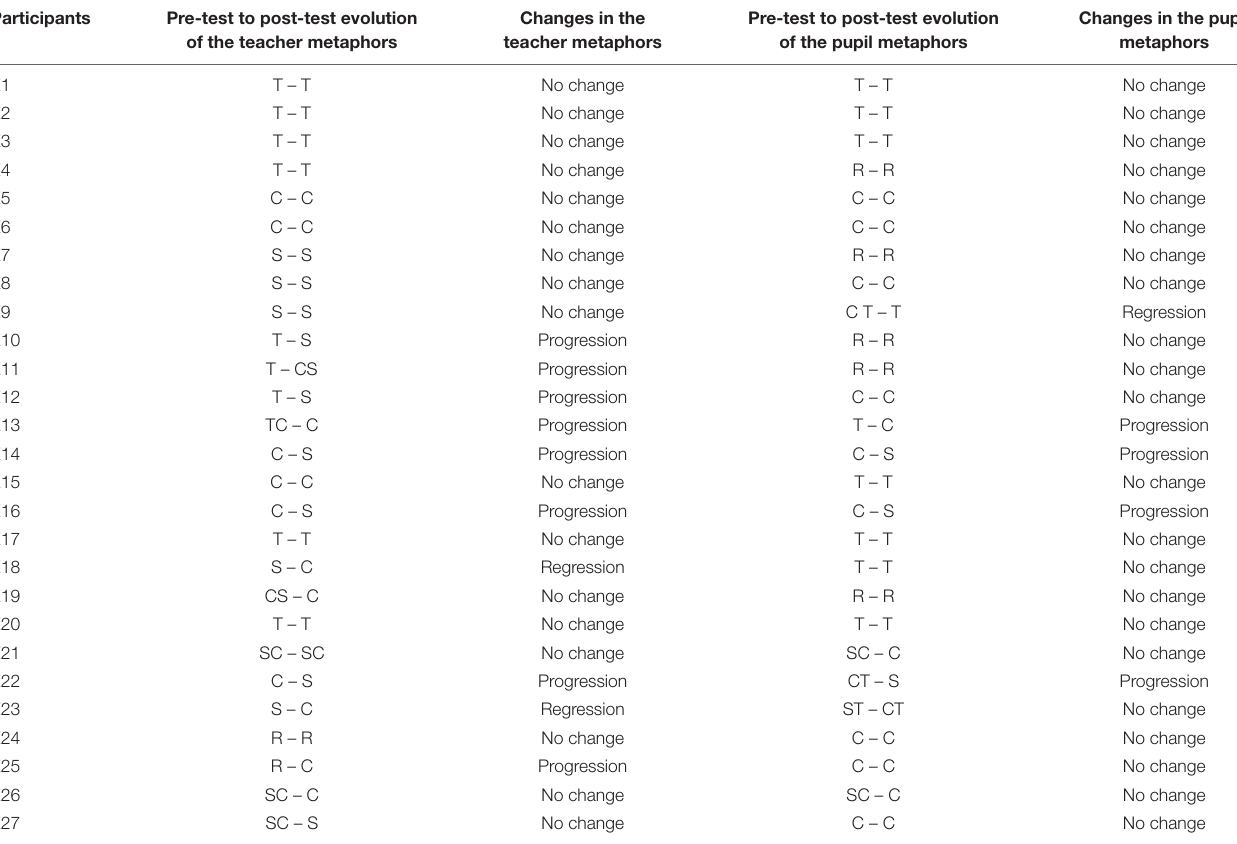
TABLE 2 | Evolutions in the teachers’ models before and after the teaching practices ( T , behaviourist/transmissive; C, cognitivist/constructivist; S, situative/socio- historical; R, self-referential). Participants Pre-test to post-test evolution Changes in the Pre-test to post-test evolution of the teacher metaphors teacher metaphors of the pupil